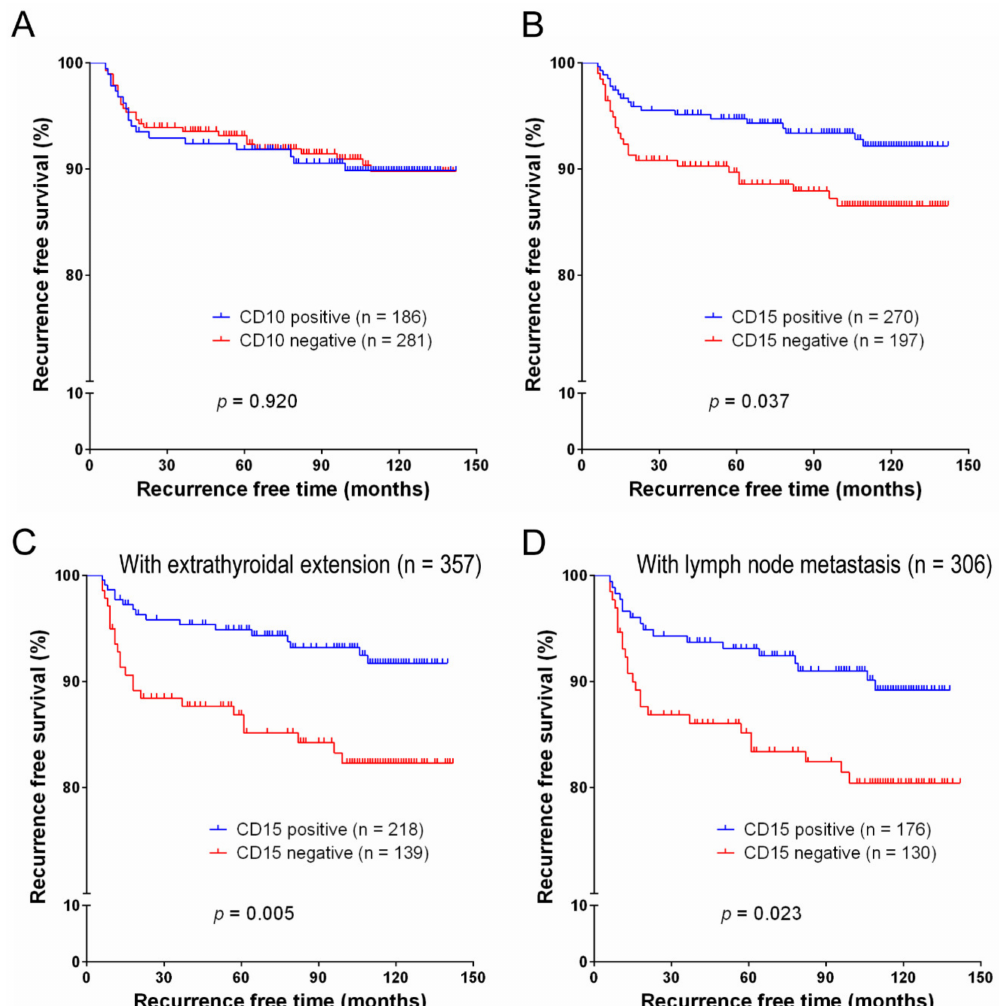
Figure 2. Recurrence-free survival analysis of CD10 and CD15 expression in 467 patients with papillary thyroid carcinoma treated with total thyroidectomy and radioiodine remnant ablation. The recurrence-free survival was not correlated with CD10 expression ( A ) but was significantly correlated with CD15 expression ( B ). Stratified survival analyses show a significant association between CD15 expression and recurrence-free survival in patients with minimal and gross extrathyroidal extension ( C ) and lymph node metastasis ( D